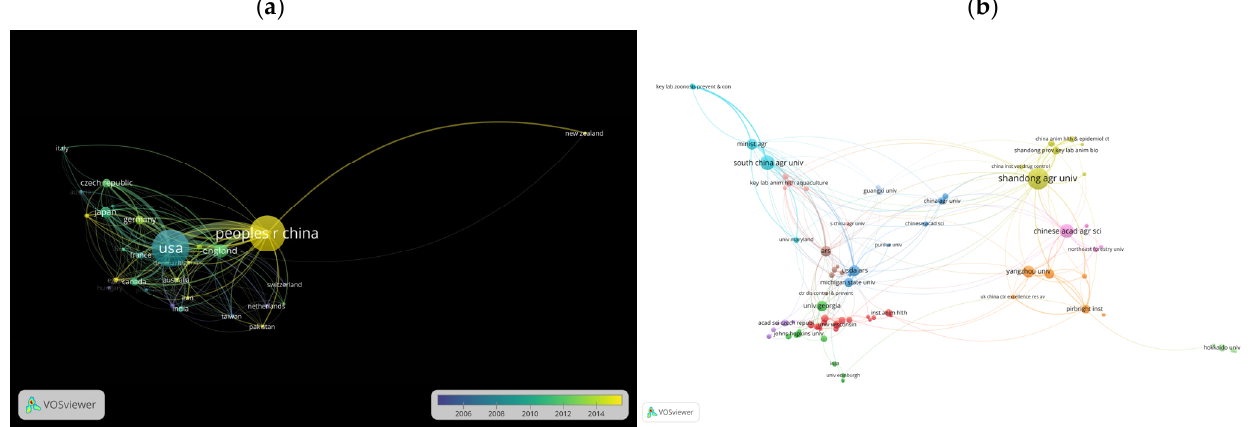
Figure 2. Influence visualization of the most influential countries and organizations in avian leukosis virus research. ( a ) Overlay visualization of prolific countries in the field of ALV research. The color difference describes the research contribution over time. ( b ) Network visualization of the most persuasive organizations in the field of ALV research. The size of a node represents the total productivity of articles, and the distance signifies how these are related to each other.